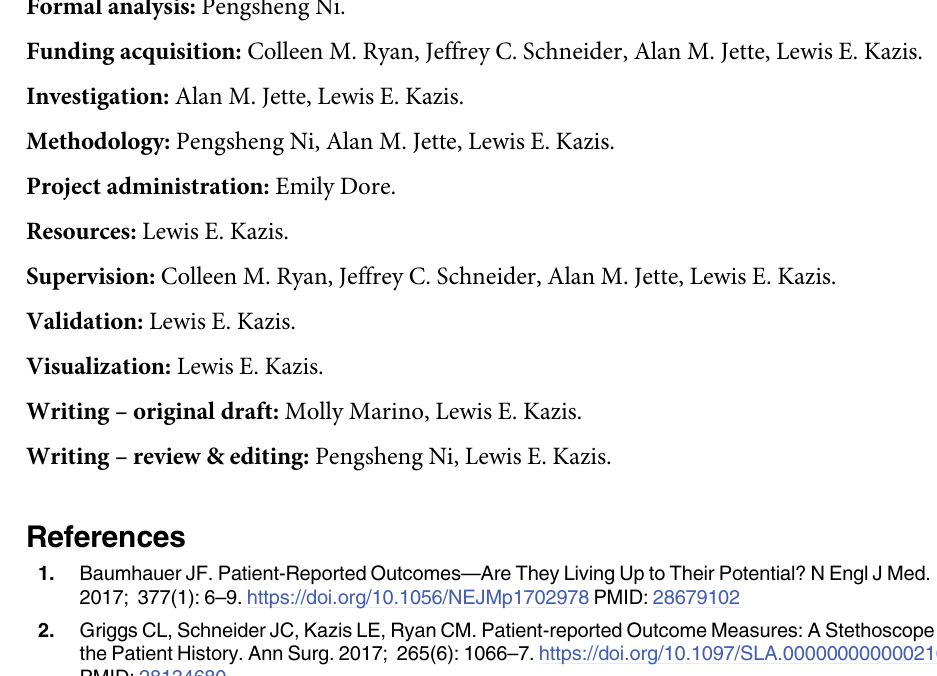
S1 Table. Response patterns and score estimations under different models. � Score 0 means higher function or better outcome, the first row is for family friend scale, the second is social interaction, the last row is the social activity scale; all the scores were in Z score